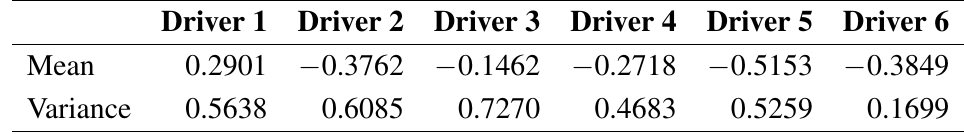
Table 6. Mean and Variance of Acceleration of Six Different Drivers.